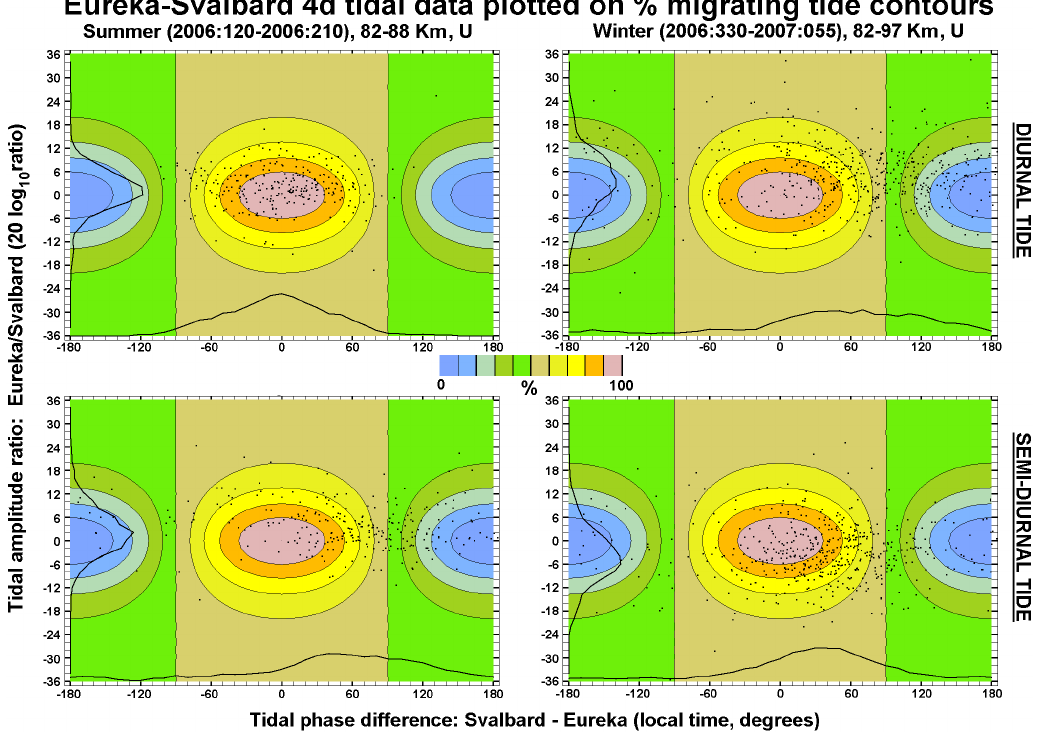
Fig. 10. Tidal amplitude ratios for the observed tides at Eureka and Svalbard versus their observed phase differences for the diurnal and semidiurnal tides. Model values are contoured in color (the scale is included in the figure), and 4-day observed tidal amplitude ratios are added as black